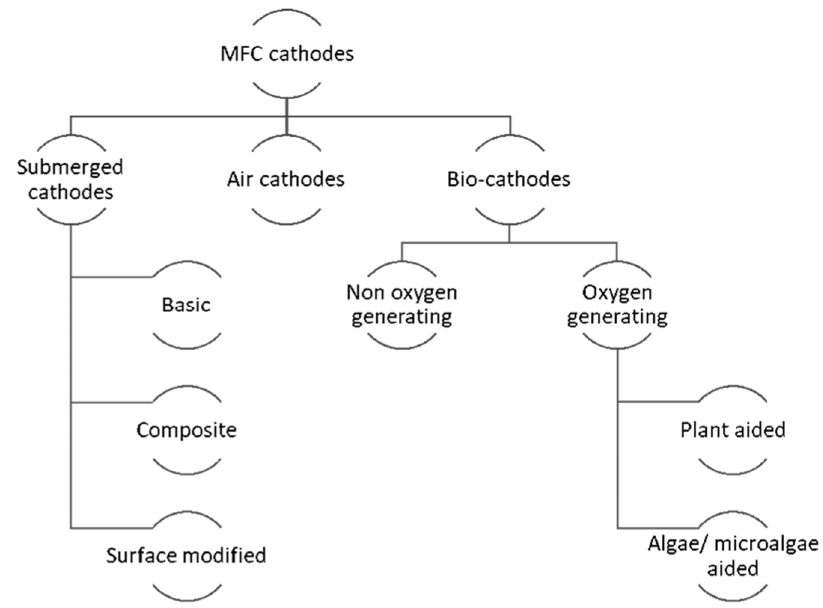
Figure 5. Classification of MFC cathodes according to their functionalities.